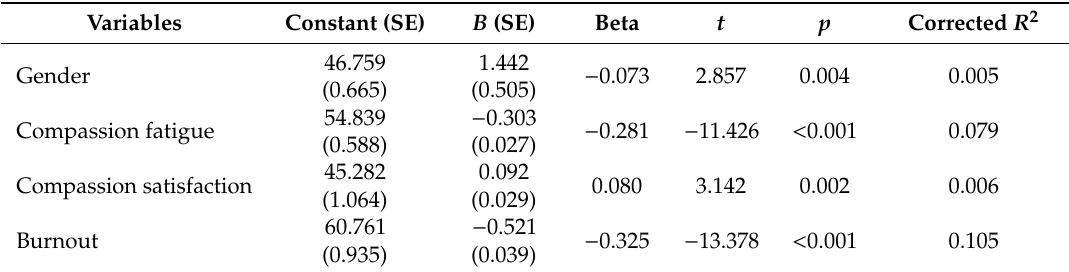
Table5. Simplelinearregressioncoe ffi cientsforthementalcomponentofHRQoL.Nursingprofessionals ( n =